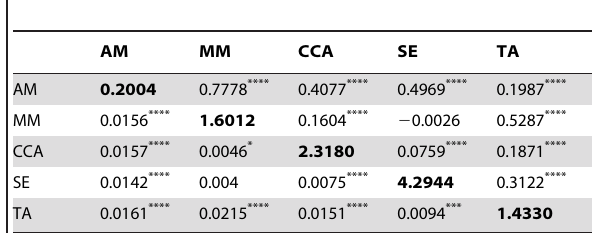
Table 3. F st value comparison for sampled populations in southern Kenya and northern Tanzania based on microsatellites below the diagonal and mtDNA above the diagonal; percent mtDNA nucleotide diversity for each population is given in bold on the